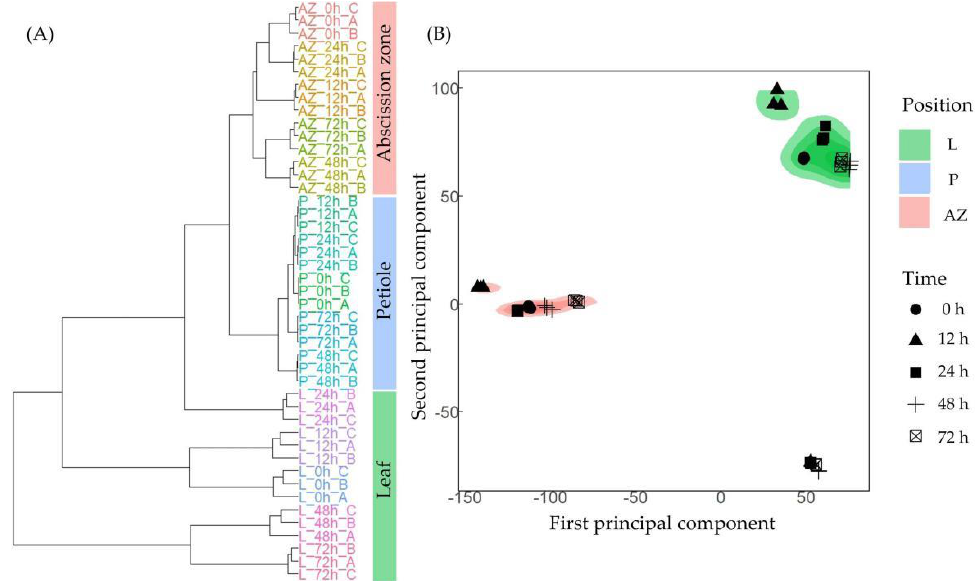
Figure 2. Transcriptome relationship among five time points of thidiazuron (TDZ) treatment in leaf (L), petiole (P), and abscission zone (AZ). ( A ) Cluster dendrogram showing three distinct tissues of leaf, petiole, and AZ. ( B ) Principal component analysis (PCA) of five time point samples in leaf, petiole, and AZ. Cotton leaves were treated with 750 mg/L thidiazuron (TDZ). Leaf, petiole, and AZ were sampled at 0, 12, 24, 48, and 72 h after treatment and were subjected to RNA-seq analyses.